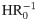
Total tibia acceleration of two similar subjects.The two subjects have the same gender (G = 1 = female), a similar body mass (BM = 71.8 kg for subject 1 and 68.5 kg for subject 2), and a similar inverse heart rate in the warm-up stage (HR0-1 = 0.00559 for subject 1 and 0.00557 for subject 2). While the value of the VARt,total,0-1 feature is low for subject 1 (0.689), it is high for subject 2 (2.30). Consequently, subject 1 has a lower VO2max (33.14 ml ⋅ kg−1 ⋅ min−1) than subject 2 (41.71 ml ⋅ kg−1 ⋅ min−1).